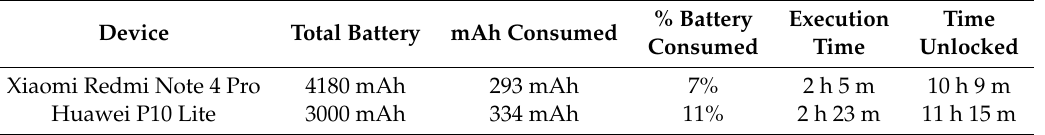
Table 8. Battery consumption of the adaptive and continuous authentication